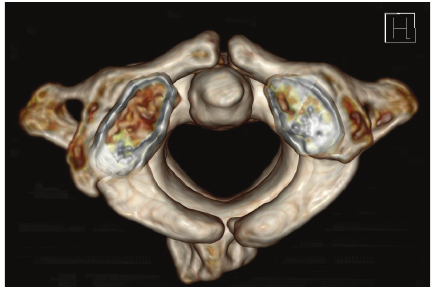
Figure 2: Bipartite